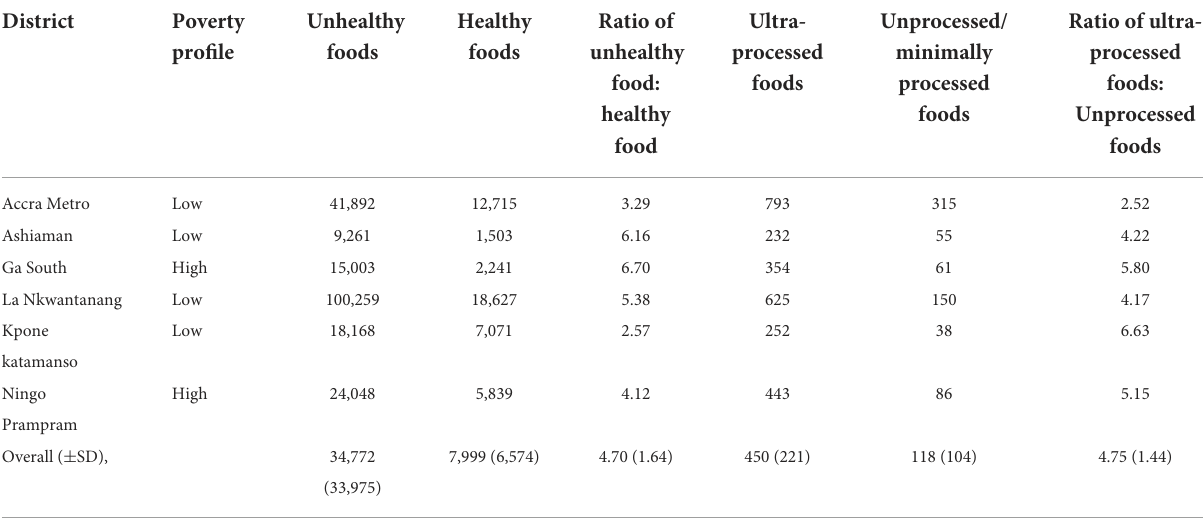
TABLE 3 Ratio of healthy/unprocessed/minimally processed foods to unhealthy/ultra-processed foods by district. District Poverty